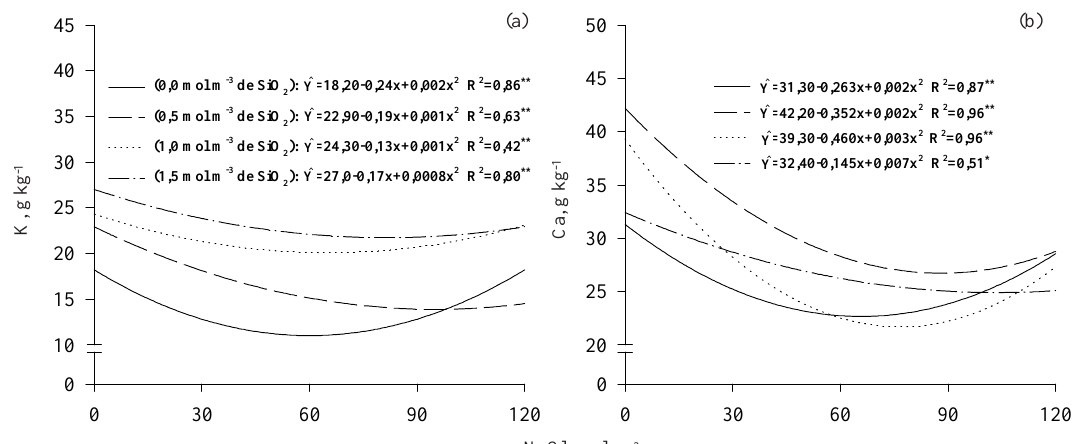
Figura 2. Teores de K (a) e Ca (b) nas folhas de moringa, considerando a concentração de NaCl e de SiO na